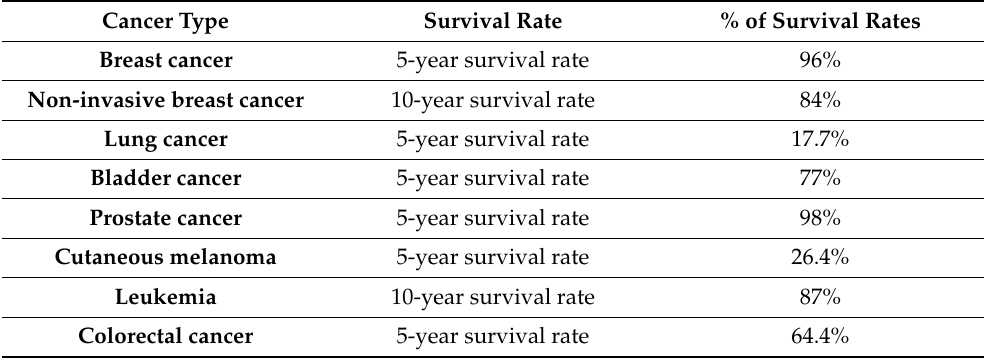
Table 1. Relative survival rates and percentages by cancer type [15–28]. Cancer Type Survival Rate % of Survival Rates Breast cancer 5-year survival rate 96% Non-invasive breast cancer 10-year survival rate 84% Lung cancer Bladder cancer Prostate cancer 5-year survival rate Cutaneous melanoma 5-year survival rate 26.4%